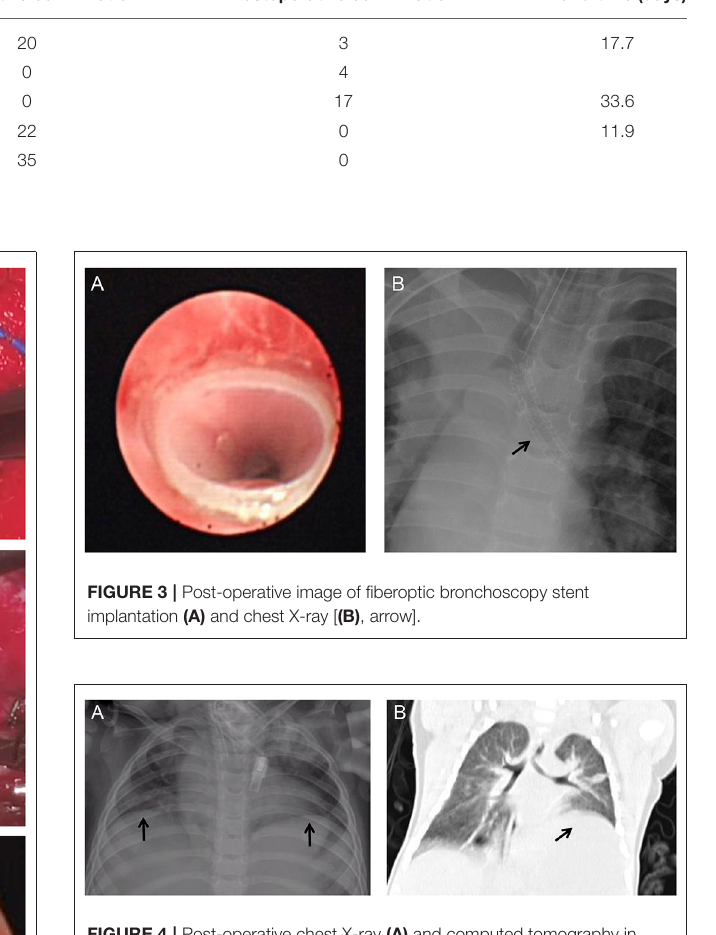
FIGURE 4 | Post-operative chest X-ray (A) and computed tomography in coronal view (B) showing the unilateral diaphragmatic elevation (arrows).